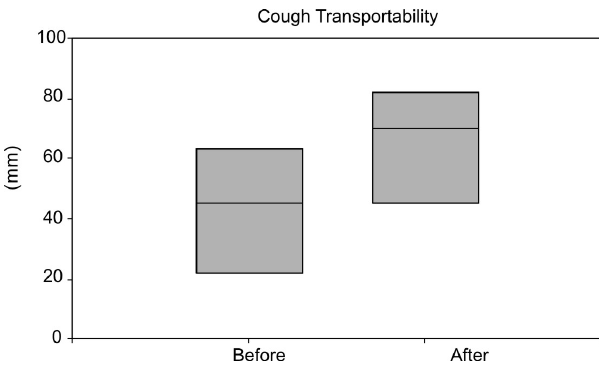
Figure 3 - Cough transportability data distribution before and after immu- noglobulin infusion in these seven patients with secretion